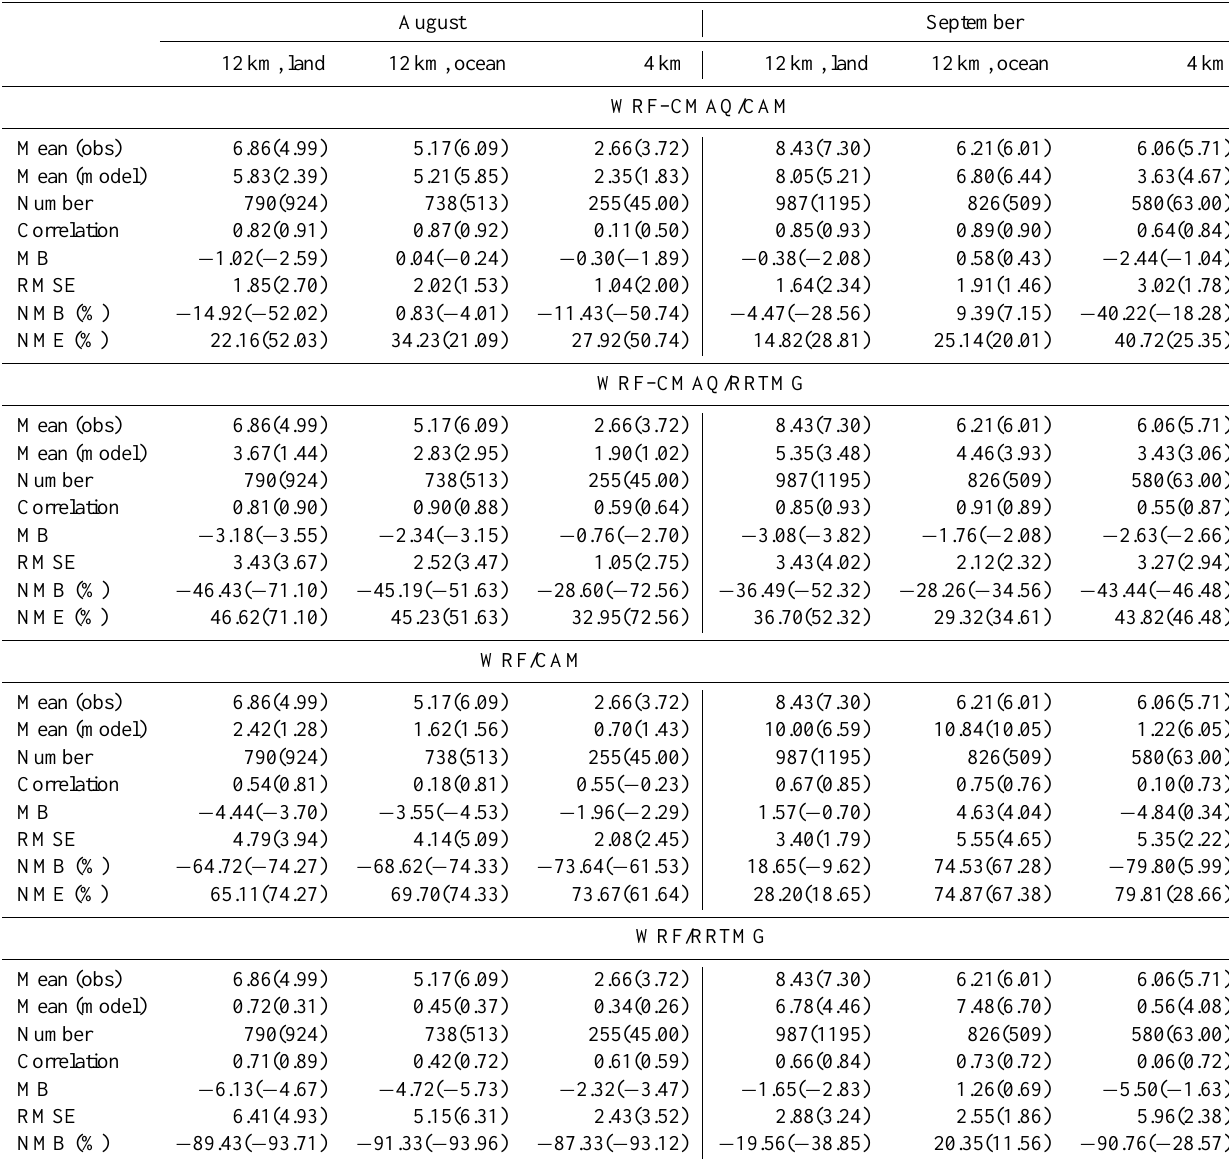
Table 11. Same as Table 9, but for monthly COD in August and September of 2006.